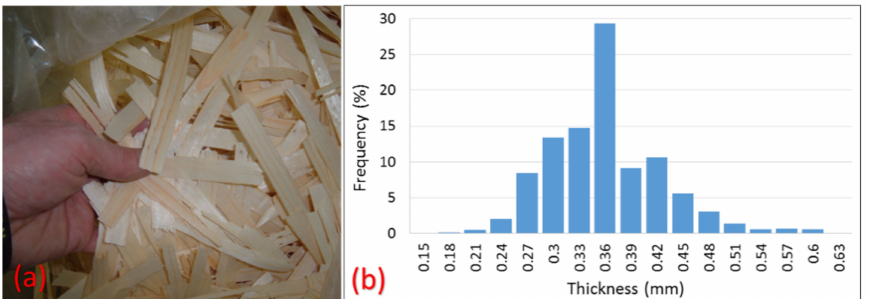
Figure 2. ( a ) Wood strands and ( b ) frequency distribution graph of their